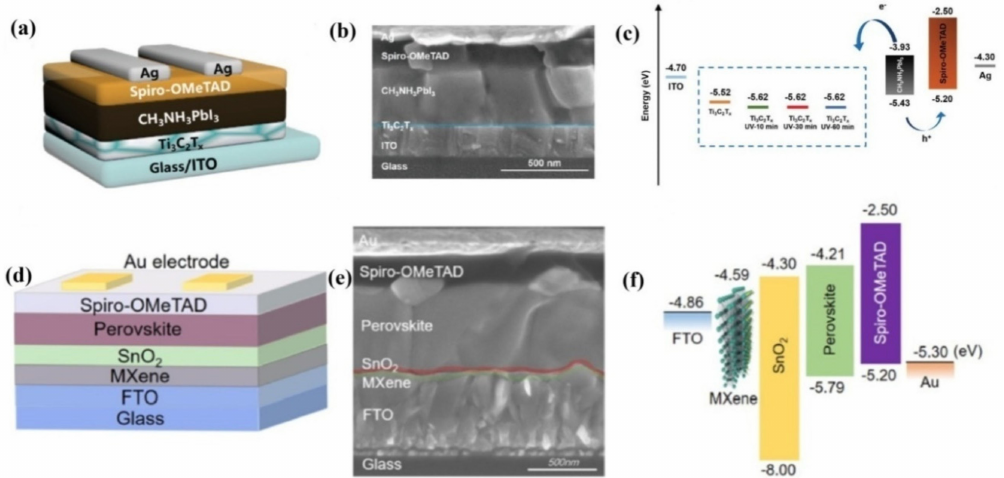
Figure 7. ( a ) Device architecture of based on Ti 3 C 2 T x with UV-ozone treatment as ETL ( b ) cross sectional SEM image of the PSC device ( c ) schematic energy-level diagram of each layer. Reprinted with permission from Ref. [83]. Copyright 2019 WILEY-VCH Verlag GmbH & Co. KGaA, Weinheim ( d ) Device configuration. ( e ) Cross-sectional SEM image of device. ( f ) Flat-band energy level diagram. Reprinted with permission from Ref. [84]. Copyright 2020 American Chemical